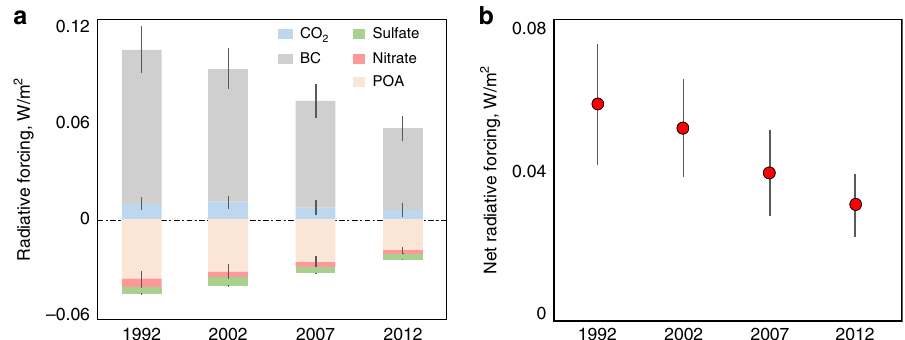
Fig. 5 Radiative forcing associated with emissions from rural residential sector. a Radiative forcing caused by CO 2 , BC, POA, sulfate, and nitrate originating from rural residential emissions in 1992, 2002, 2007, and 2012. b The net forcing of these components. Error bars indicate standard deviations generated from the Monte Carlo simulation. Source data are provided as a Source Data fi